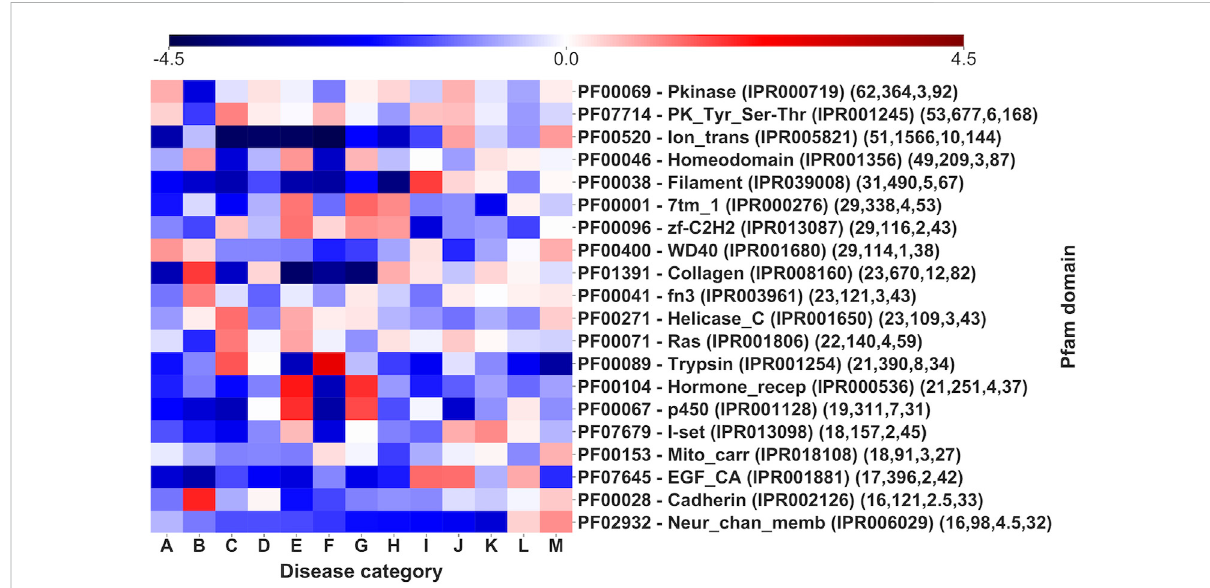
FIGURE 7 Log-odd scores for disease categories associated to different Pfam domains. Log-odds are calculated with respect to the whole-dataset background of disease categories (Supplementary Table S4). For each Pfam the corresponding InterPro accession is indicated. Numbers in parentheses report the number of genes, of SRVs, the median number of SRVs per gene and the number of diseases (for statistical validation see Supplementary Table S4).